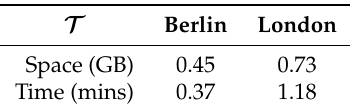
Table 5. MDTM ALT-based preprocessing time and space requirements for the extended Berlin and London instances with unlimited walking travel